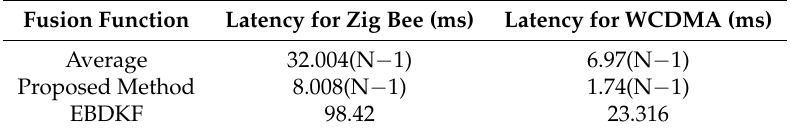
Table 3. Network Latency of different information fusion functions for chain-based